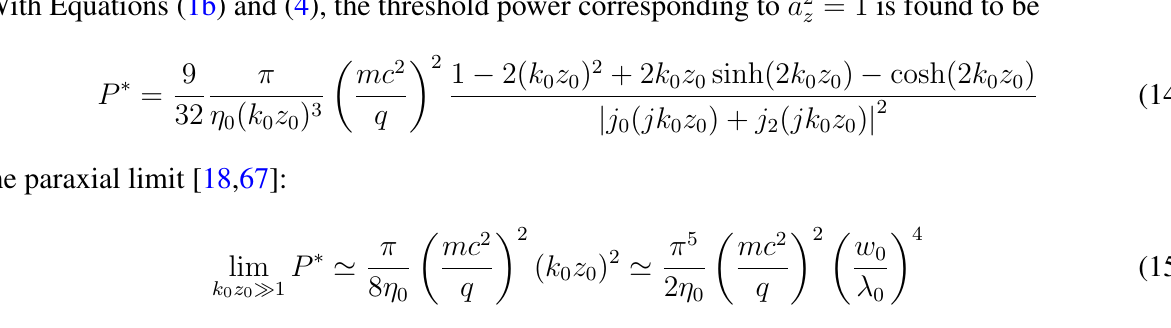
Figure 2. Overview of electron acceleration in RPLBs. The far right of the